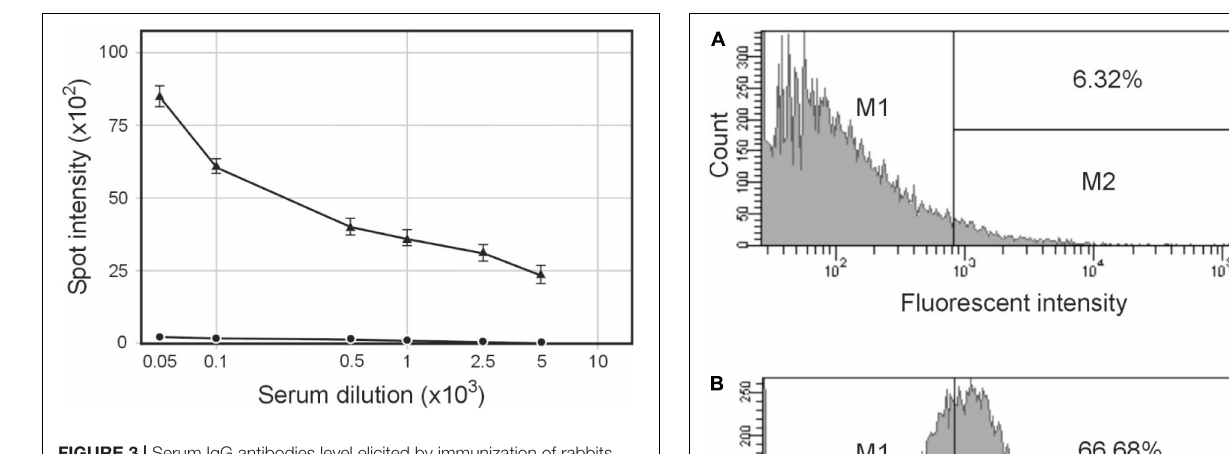
FIGURE 3 | Serum IgG antibodies level elicited by immunization of rabbits with pBSKS:: (cid:56) 6fm(Hin) phagemid particles. Sera were analyzed by quantitative dot ELISA. H. influenzae Rd30 cells (2 × 10 8 cells/ml) diluted in PBS were spotted on a nitrocellulose strip and allowed to dry. Titers of IgG polyclonal antibodies were collected on day 28 after immunization. The intensity of the color of each spot was expressed as the change of the spot intensity compared with the negative control where spotting was omitted. For each point, four spots were analyzed. anti- H. influenzae antibodies bound to the spots. Line: